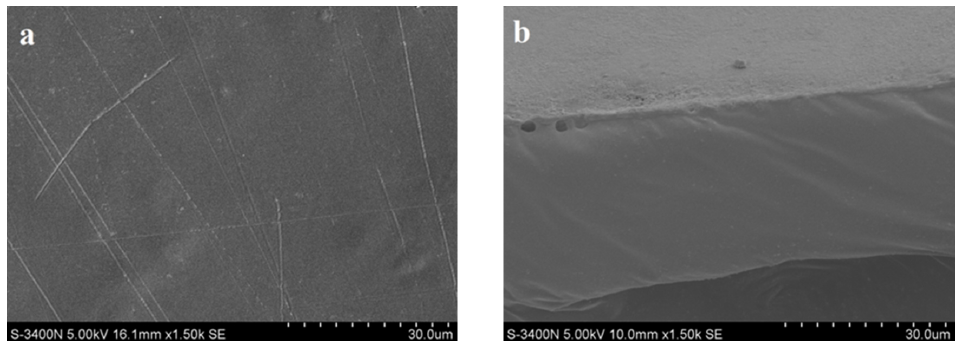
Figure 5. SEM images of the surface ( a ) and cross section ( b ) of Film 4.